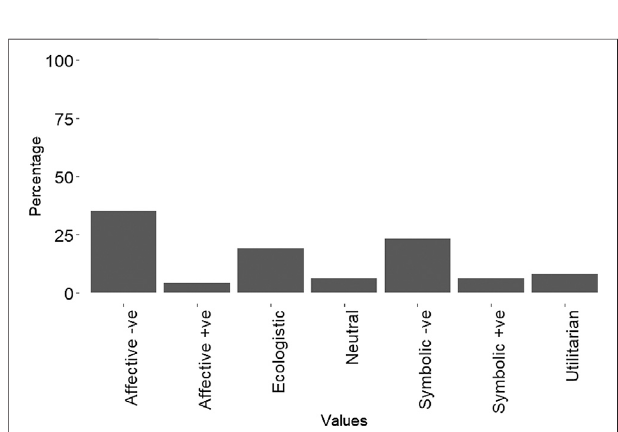
FIGURE 3 | The predominant values associated with the wolf were negativeaffective(34.6%),referringtoemotionslikefear,hatred,aversionorto retaliation, and negative symbolism (23%), associating the animal with negative cultural beliefs and values. These were followed by